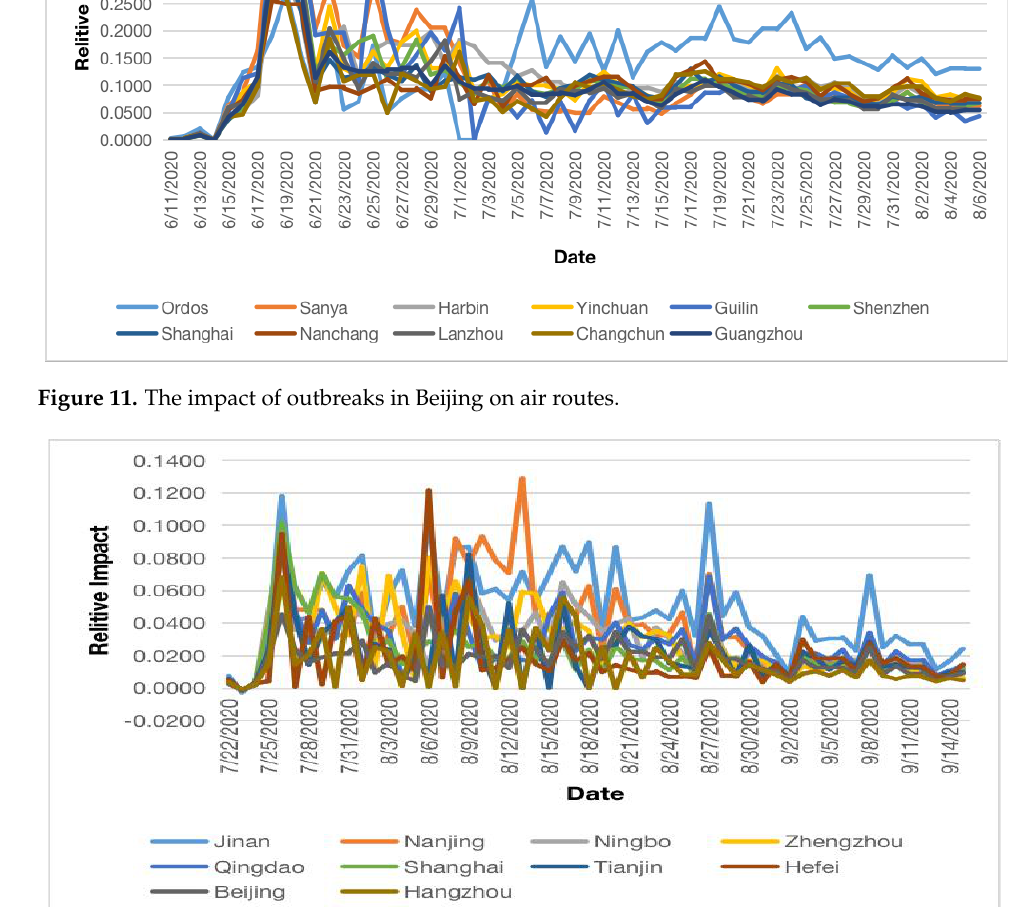
Figure 12. The impact of outbreaks in Dalian on air routes.